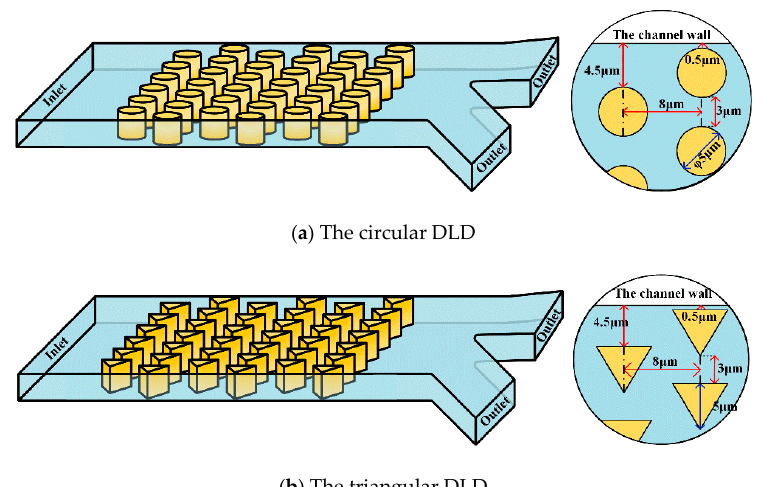
Figure 1. Schematic of a deterministic lateral displacement array device. The microfluidic channel has an inlet on the left and two outlets on the right. The circular and triangular obstacles in the channel are made of polydimethylsiloxane (PDMS). The obstacles are periodically arranged, and each row is horizontal in terms of one row and offset. A liquid solution carrying rigid microspheres of different sizes flows through the passage from the inlet. The pillar shape within the DLD device is ( a ) circular and ( b ) triangular.